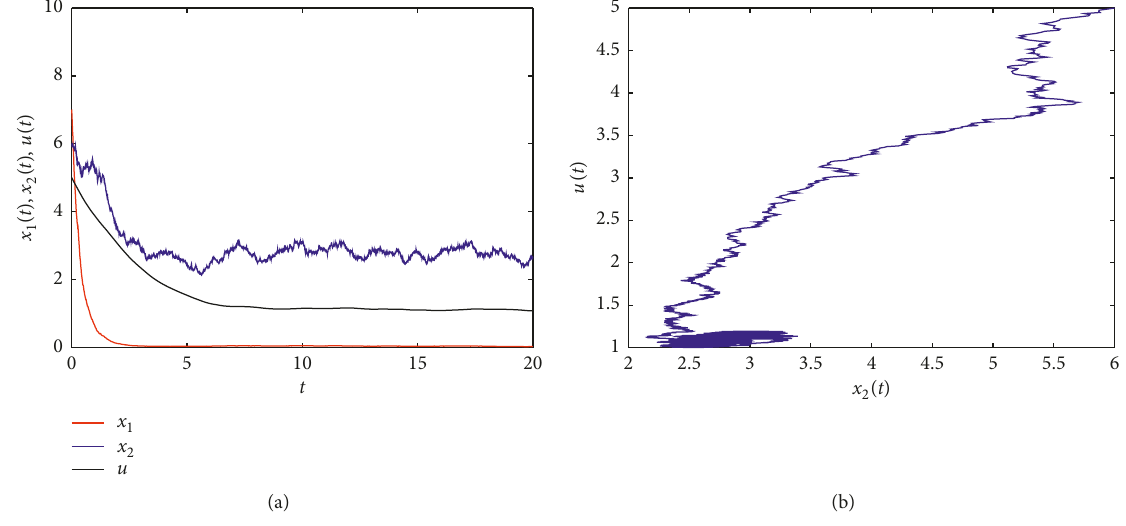
Figure 4: (a) Time series diagram of ( x